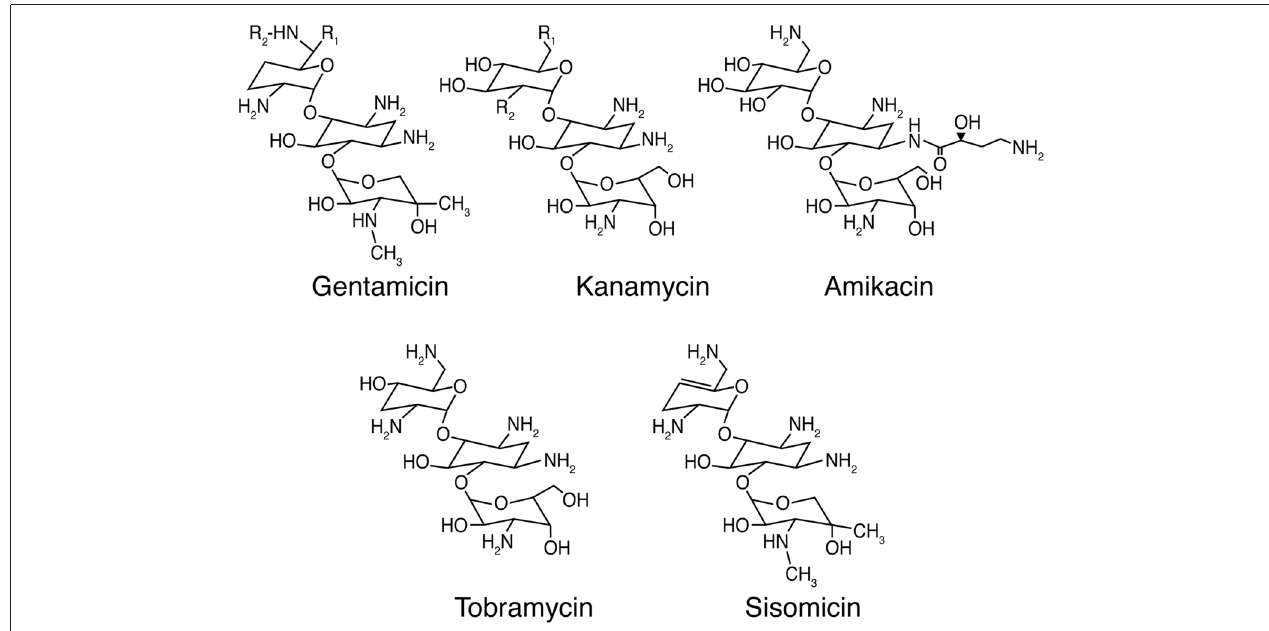
FIGURE 1 | Chemical structures of selected aminoglycoside antibiotics. For gentamicin C 1 : R 1 = R 2 = CH 3 ; gentamicin C 2 : R 1 = CH 3 , R 2 = H; and gentamicin C 1A : R 1 = R 2 = H. For kanamycin A: R 1 = NH 2 , R 2 = OH; kanamycin B: R 1 = R 2 = NH 2 ; and kanamycin C: R 1 = OH, R 2 = NH 2